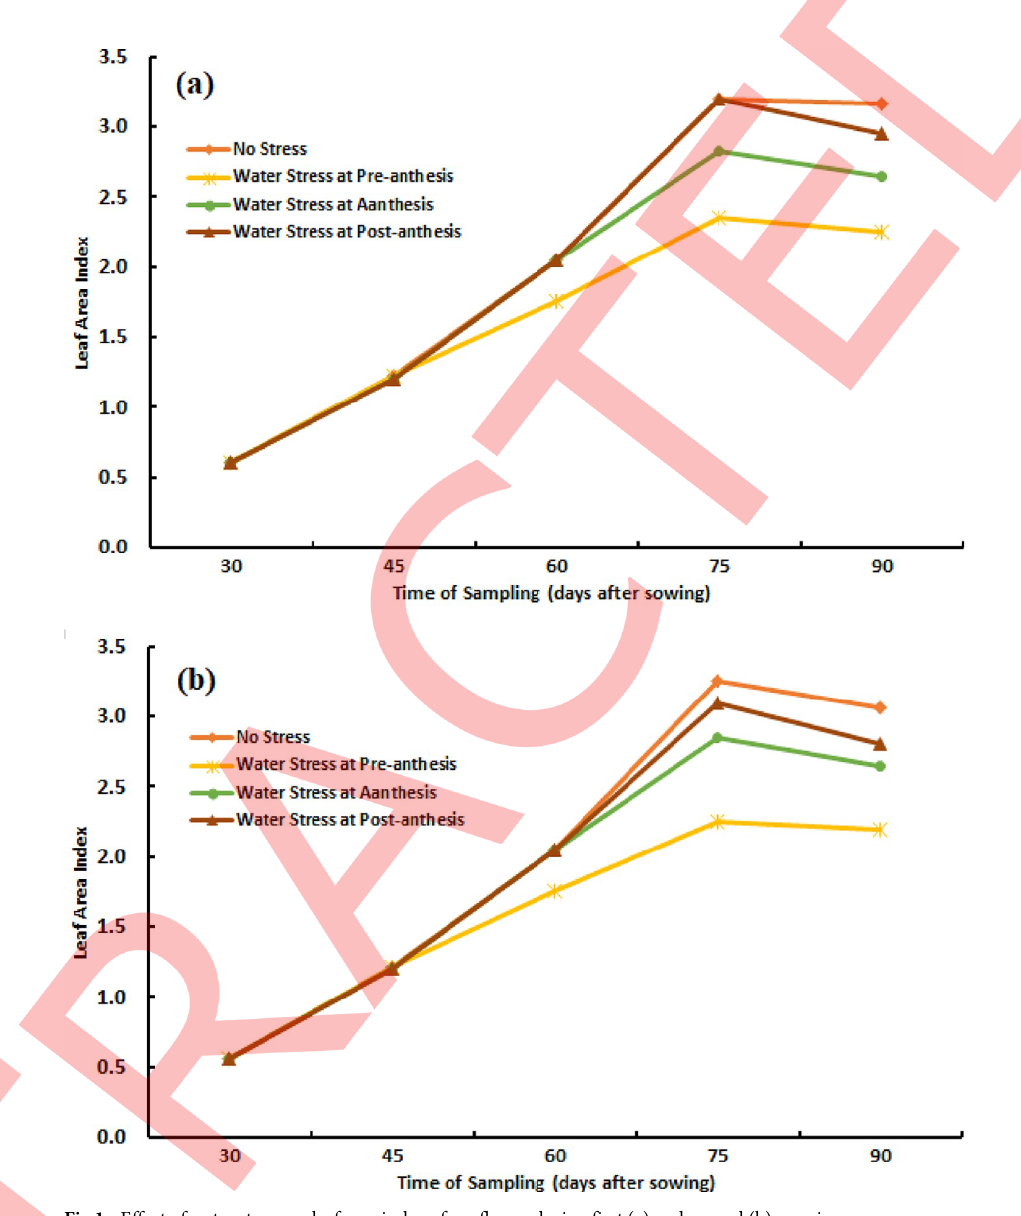
Fig 1. Effect of water stress on leaf area index of sunflower during first (a) and second (b) growing seasons.